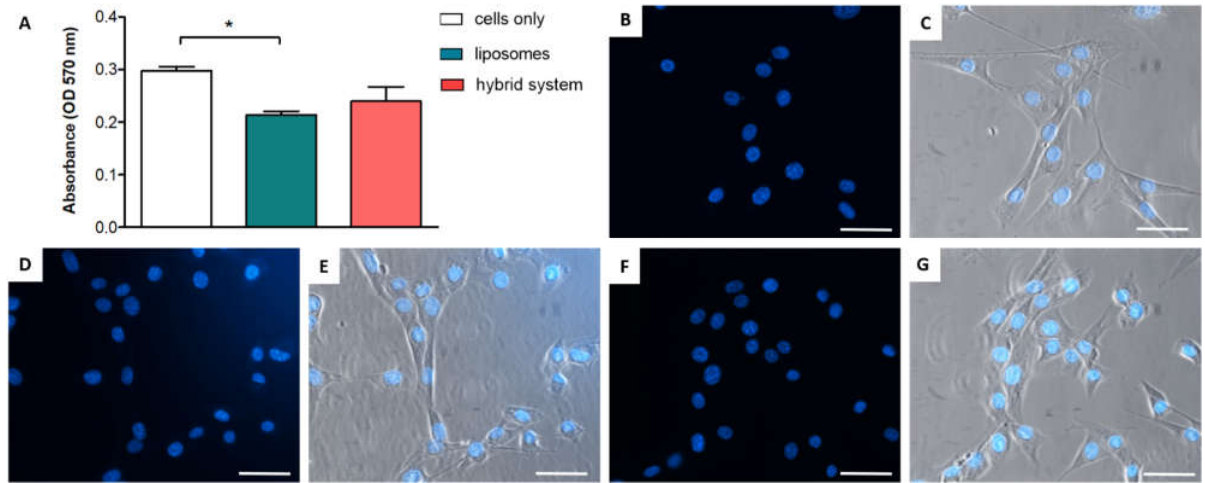
Figure 4. ( A ) Biocompatibility test by MTT assay after 24 h of incubation with liposomes and the hybrid system; cells without any treatment were used as a control. * p -value < 0.05. Fluorescence and merged (combined with bright field) microscopy analyses of fibroblasts (BALB/3T3 cells) after 24 h for control cells ( B , C ), cells incubated with liposomes ( D , E ), and cells incubated with the hybrid system ( F , G ). In all figures, the scale bar is 50 µm.